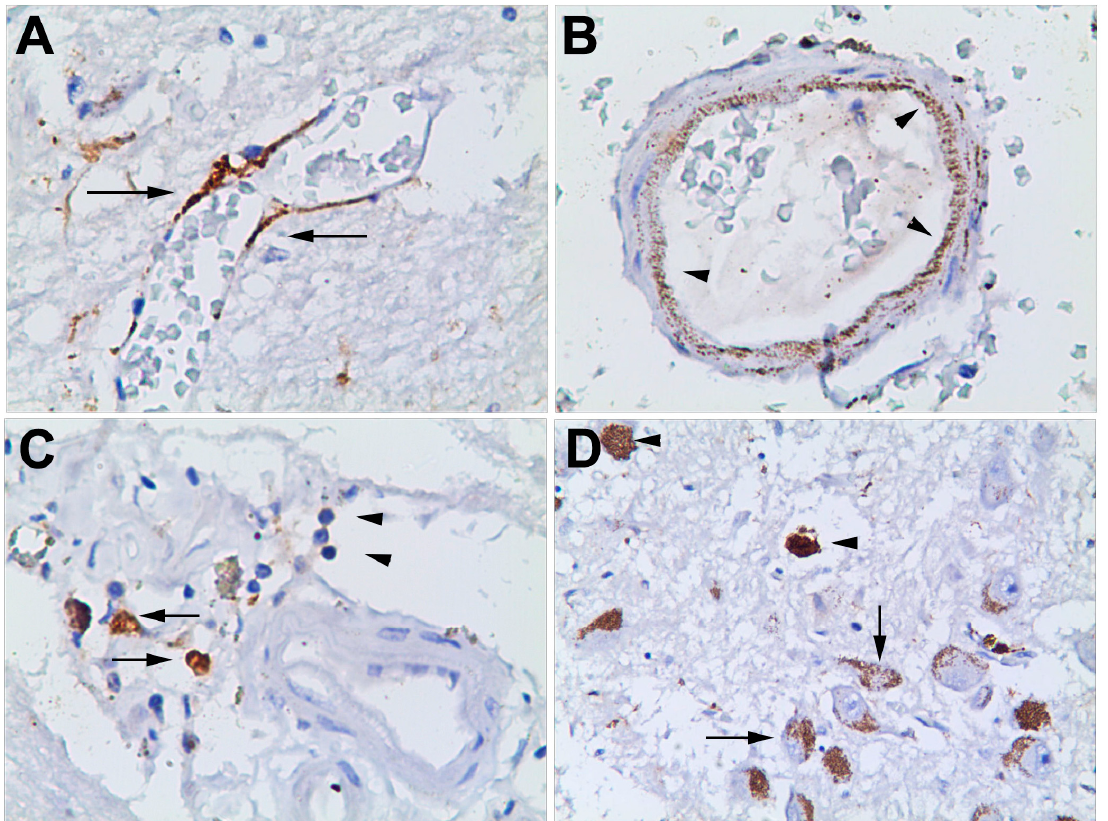
Figure 3. In some samples, within a certain stage (<24 h) of haemorrhage development, strong staining was observed within capillary endothelial cells, especially within the haemorrhagic area (Figure 1A,B; arrows). In severely damaged areas, mCRP was more strongly observed (Figure 1C, arrows), associated within the infiltrating macrophages and inflammatory cells (Figure 1C, arrowheads). We also detected clusters of neurons loaded with mCRP (Figure 1D, arrows) along with scattered lipofuscin-like deposits (Figure 1D, arrowheads).